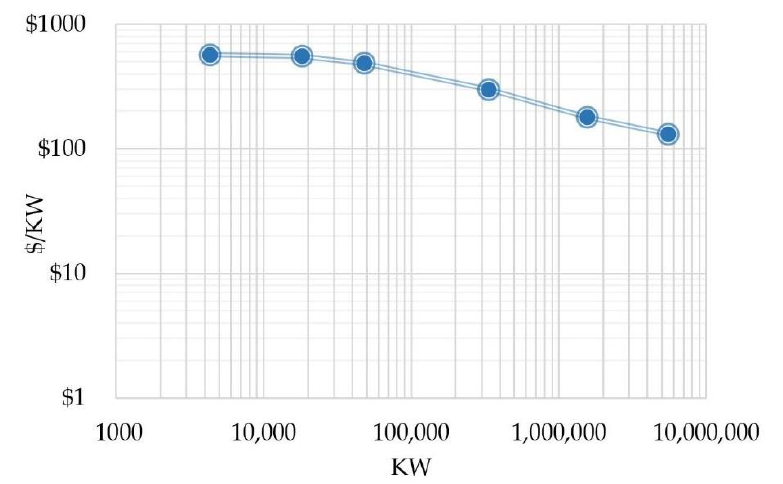
Figure 1. $ / kW cost of electromechanical equipment for hydro plants by power capacity. Figure 1. $/kW cost of electromechanical equipment for hydro plants by power capacity.